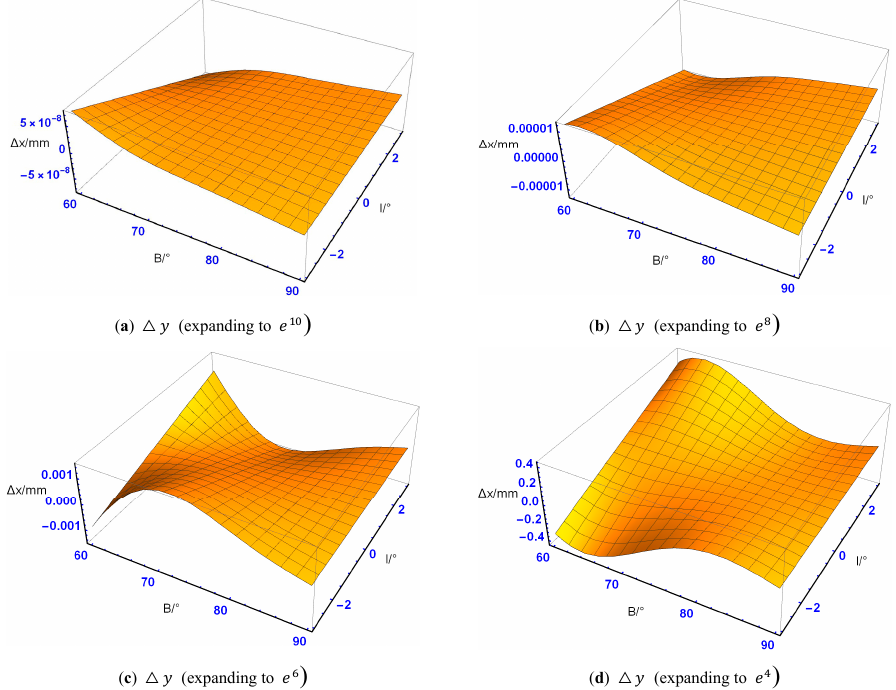
Figure 5. The distribution of the ordinate truncation difference ∆ y when expanding to e 10 , e 8 , e 6 , and e 4 .